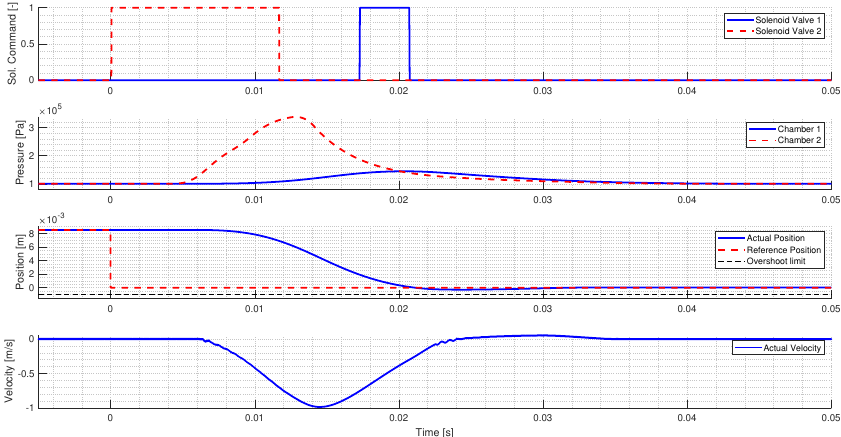
Figure 4. Neutral to High gear change (simulation).